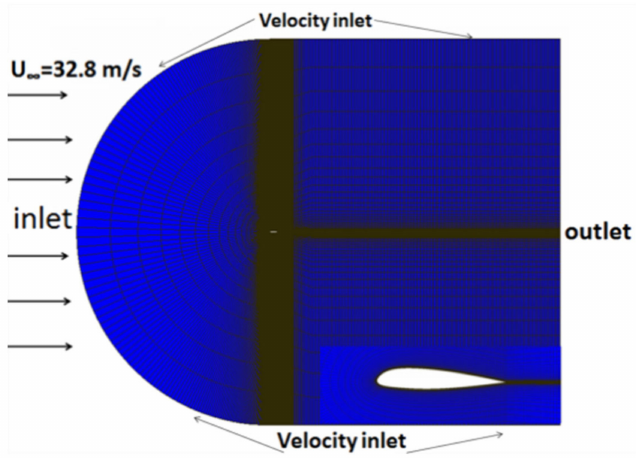
Figure 5. Computational mesh for Aerospatiale